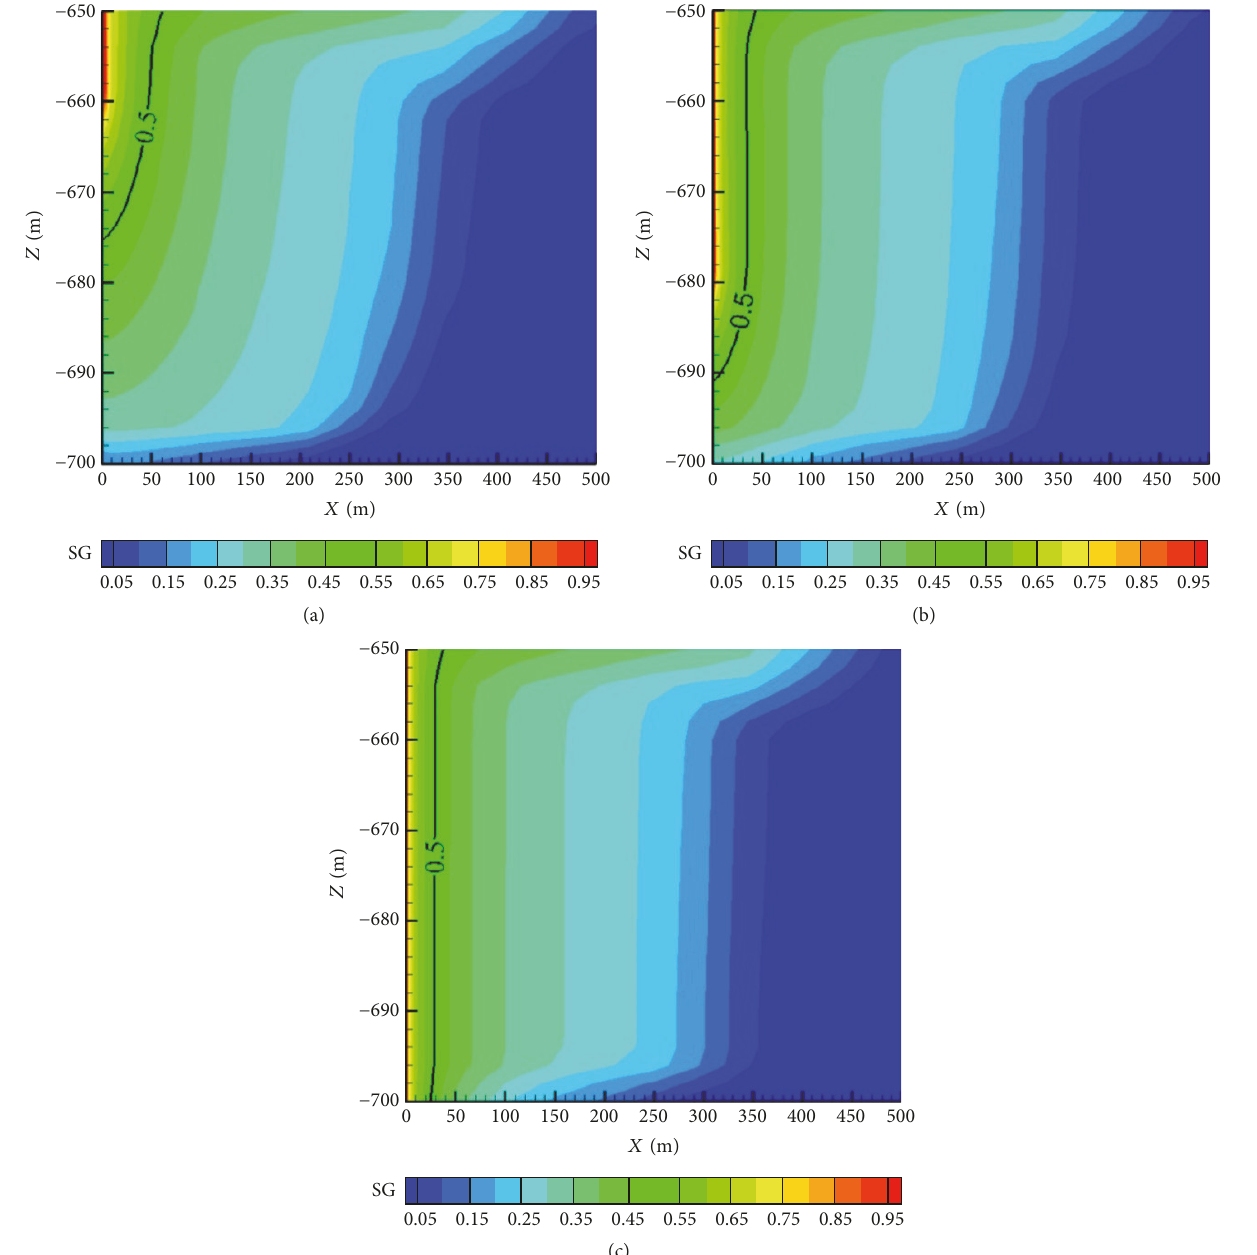
Figure 4: Gas saturation distribution for the three cases after a 30-day injection period in the aquifer. (a) Case 1 (10m). (b) Case 2 (30m). (c) Case 3 (50